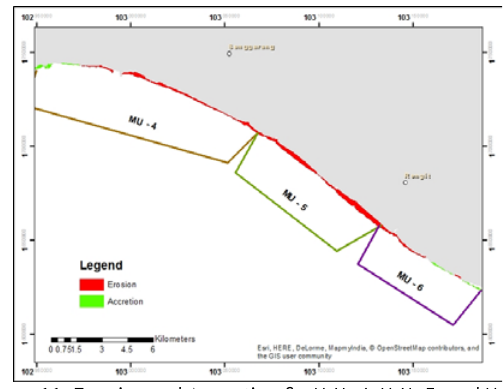
Figure 11. Erosion and Accretion for MU-4, MU-5, and MU-6 Refer to Table 5 show different coastline data represent as erosion and accretions. The result shows all section of MU has a